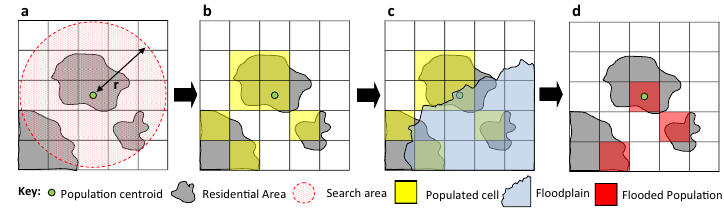
Figure 6. Method to calculate exposed population: (a, b) population is spread from centroid points to a raster grid according to specified search area (see Appendix A), (c) floodplain is overlain and (d) exposed population